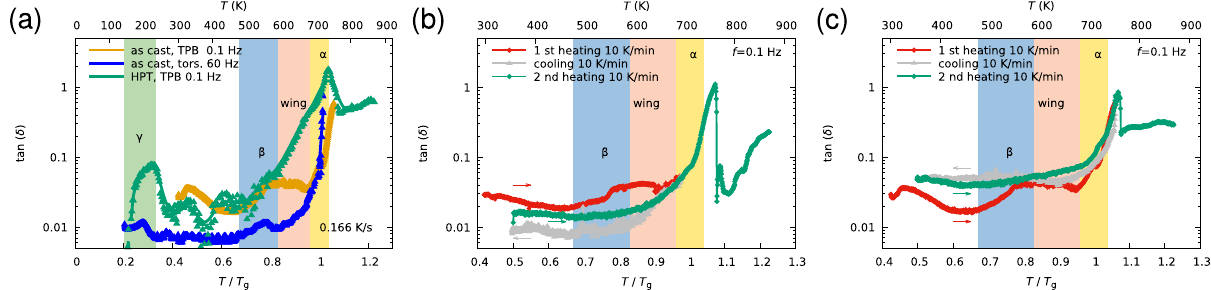
Fig. 5 Kinetics of α -, β -, and γ -transitions. a DMA Experiments on as-cast and HPT-deformed material. b β -transition upon heating just below T g and ( c ) upon heating deep into the undercooled liquid. In accordance with the previous fi gures, the transition intervals (shown in color) are derived from the torsion curve represented in ( a ).